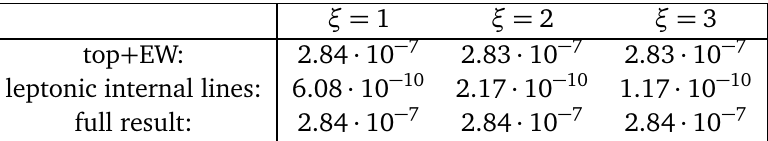
Table 5: Comparison between the purely top + electroweak contributions, strictly di- agrams with internal leptonic lines, and the full calculation of the one-loop squared contribution to H → ττγ . Errors are approximately per